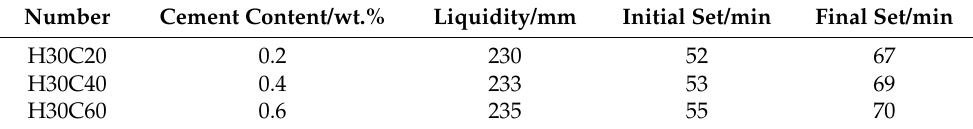
Table 4. Effect of cement content on fluidity and setting time of phosphogypsum